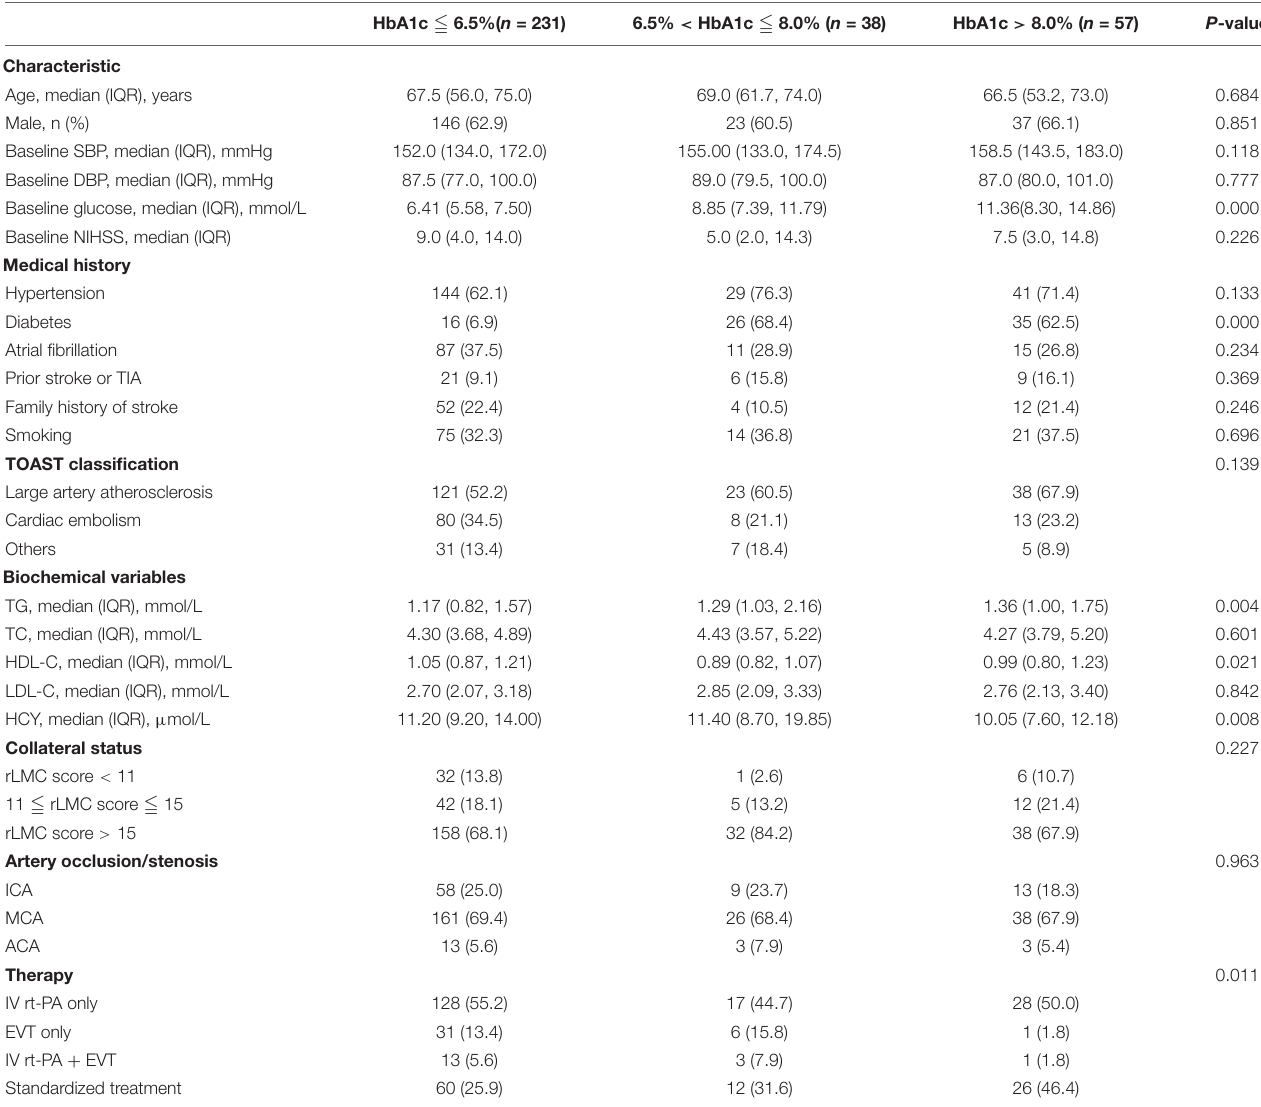
TABLE 1 | Baseline clinical and biochemical characteristics, according to HbA1c